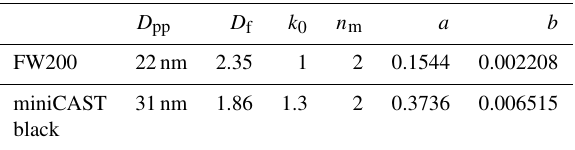
Table E2. Parameters used in Eq. (9) to calculate the activated frac-